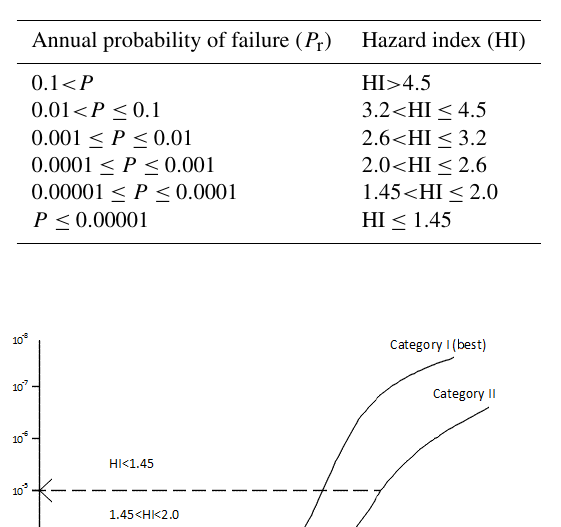
Table 7. Annual probability of failure for HI values, according to Fig. 4.